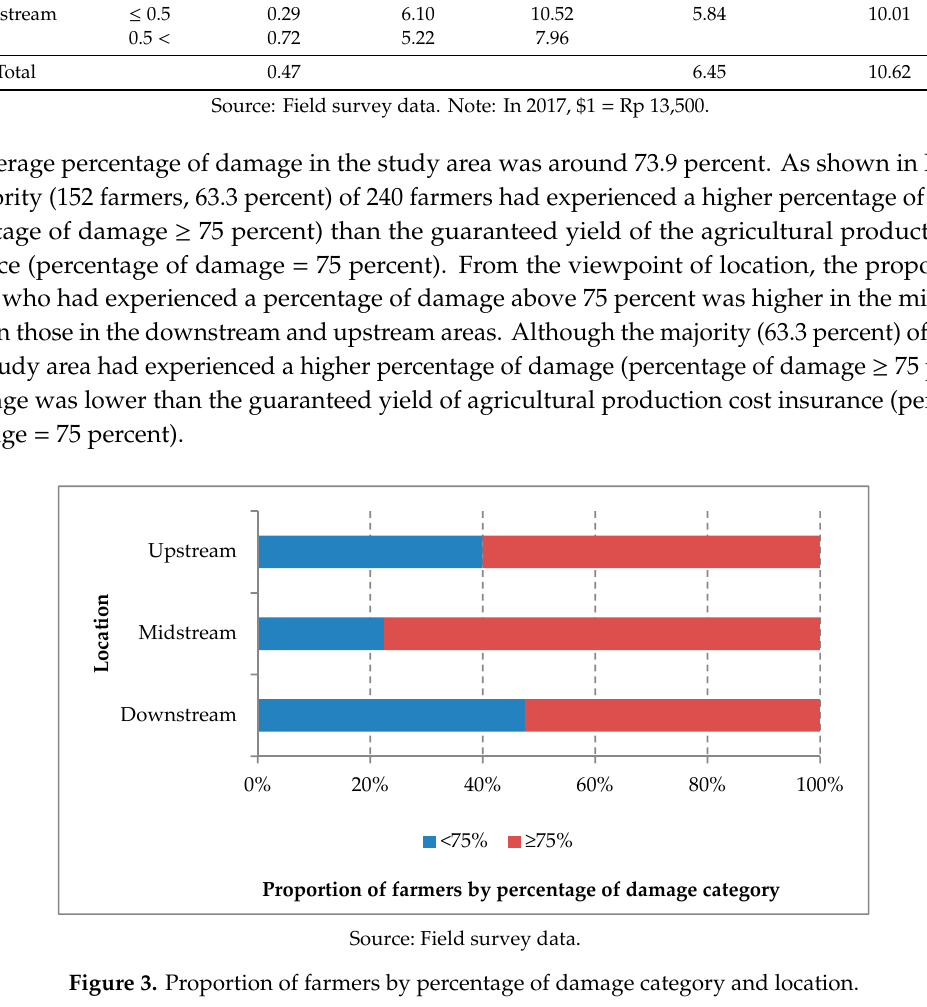
Figure 3. Proportion of farmers by percentage of damage category and location.